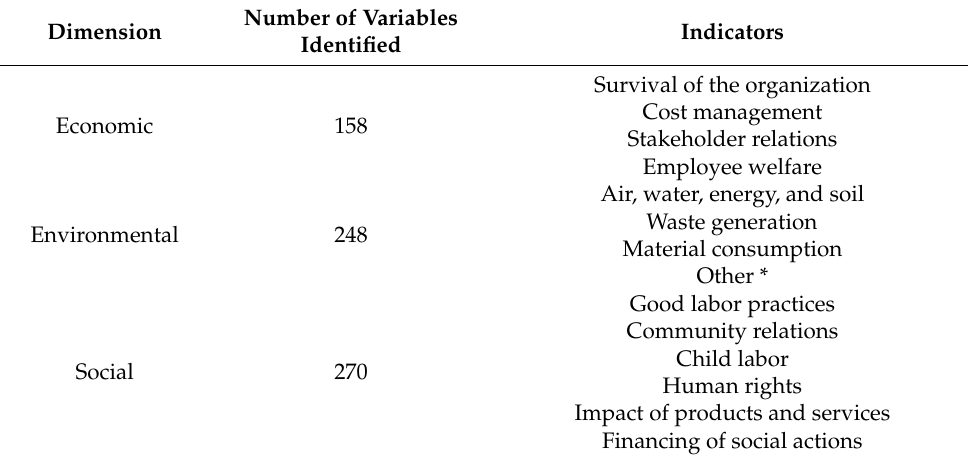
Table 2. The most valued indicators of the different sustainability models of project management in the areas of engineering and administration, according to Martens and